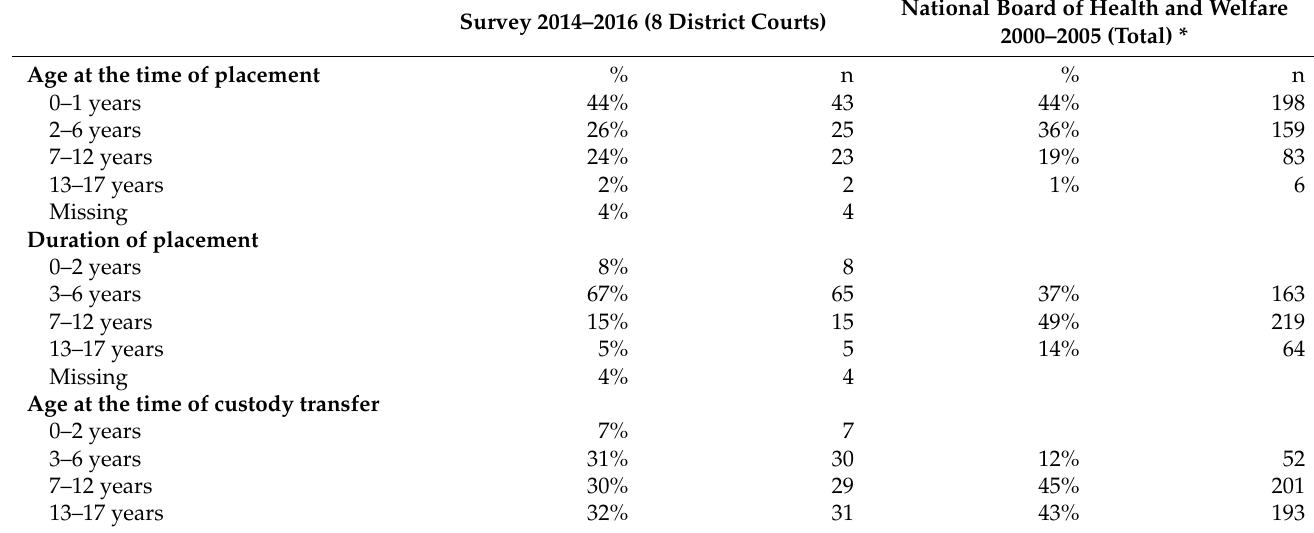
Table 2. The child’s age and duration of